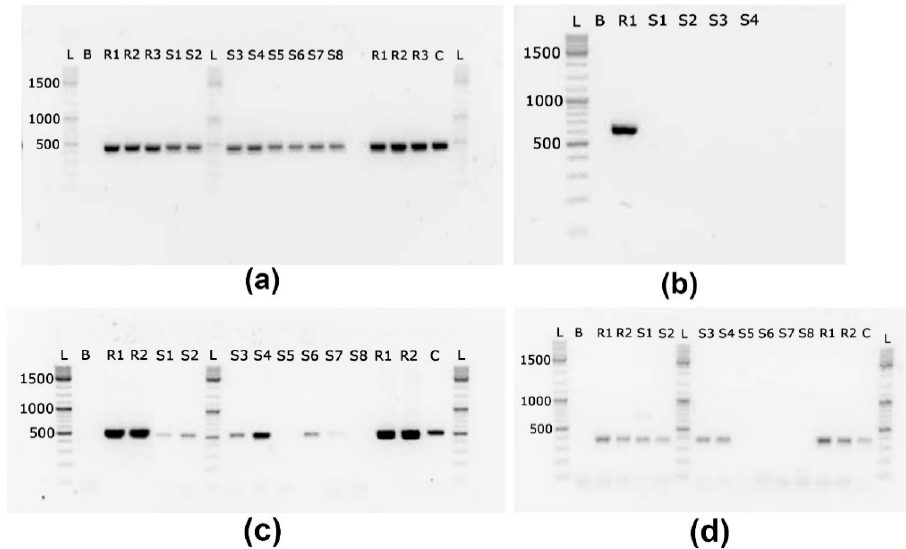
Figure 3. Visualization of PCR products on agarose gel: ( a ) mcyE ; ( b ) sxtA ; ( c ) sxtG ; ( d ) sxtS . Legend: Visualization of PCR products on agarose